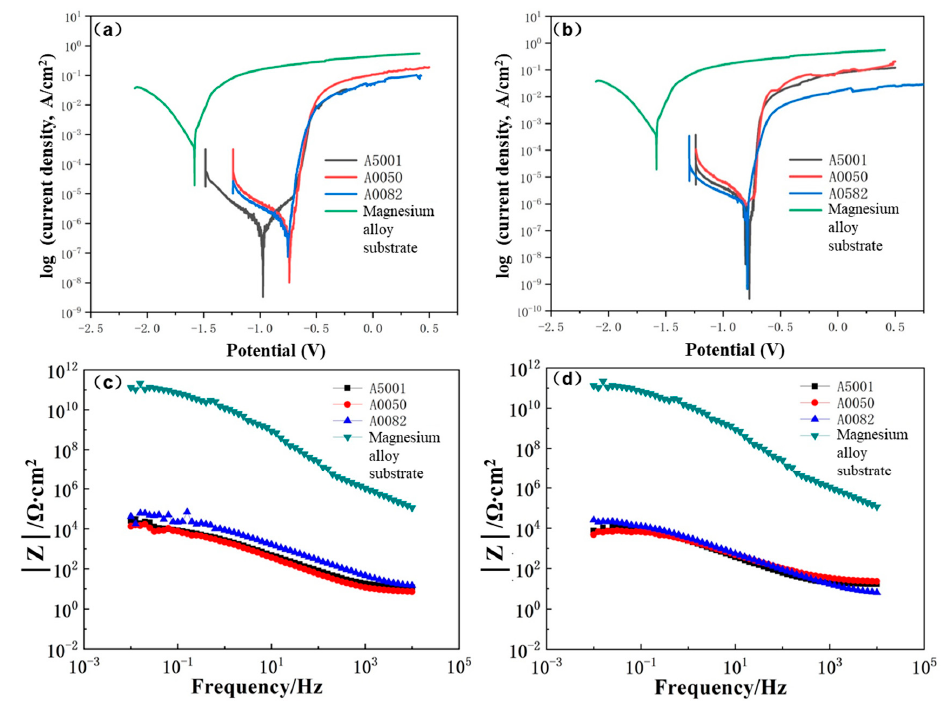
Figure 8. Polarization curves and impedance curves of magnesium alloy substrate and coatings with di ff erent thicknesses of three powders: ( a , c ) 0.5 mm; ( b , d ) 1 mm.